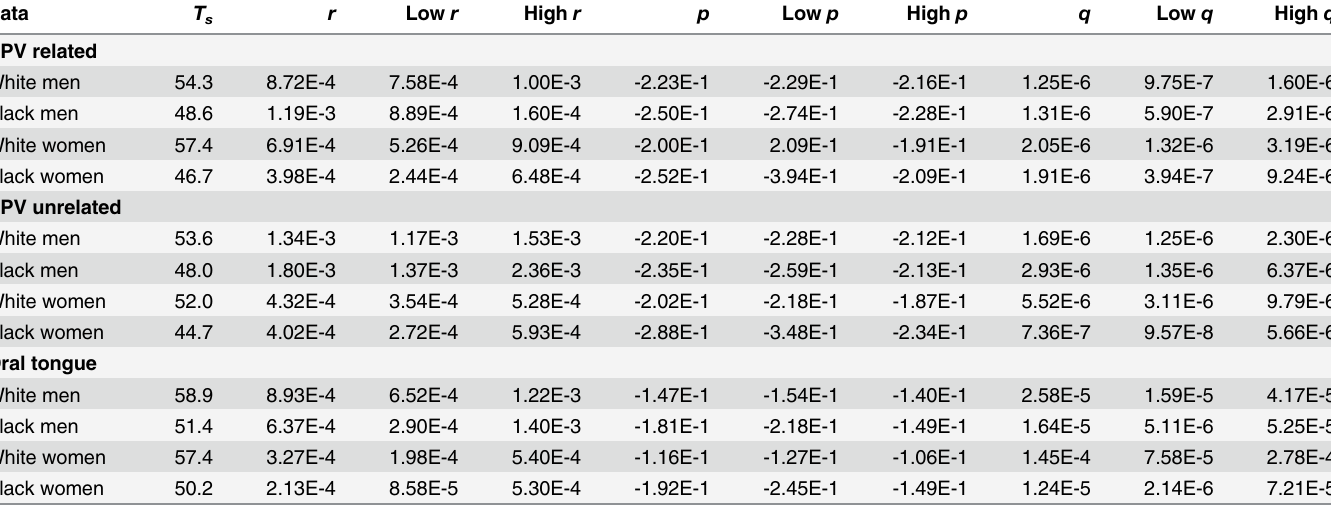
Table 2. Biological parameters for the period-and-cohort-on- r APC — TSCE models of oral squamous cell carcinoma by race and cancer subsite group with 95% Wald confidence